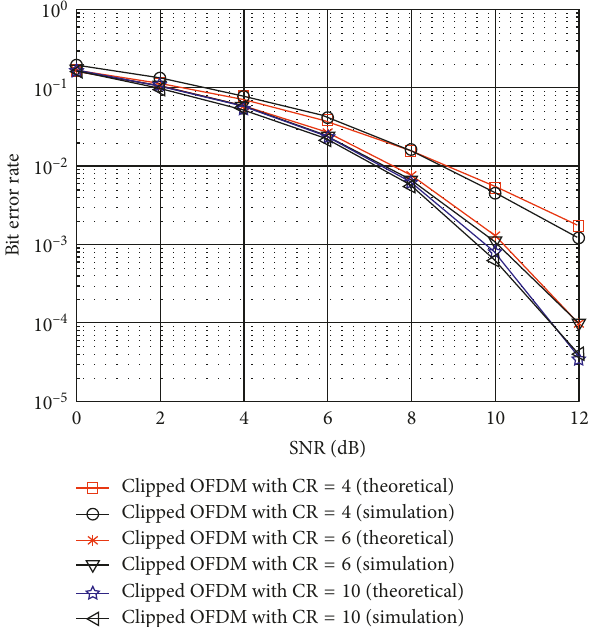
Figure 4: BER performance comparison for different clipping ratios by simulation and theoretical methods over the AWGN channel without the normalization case.